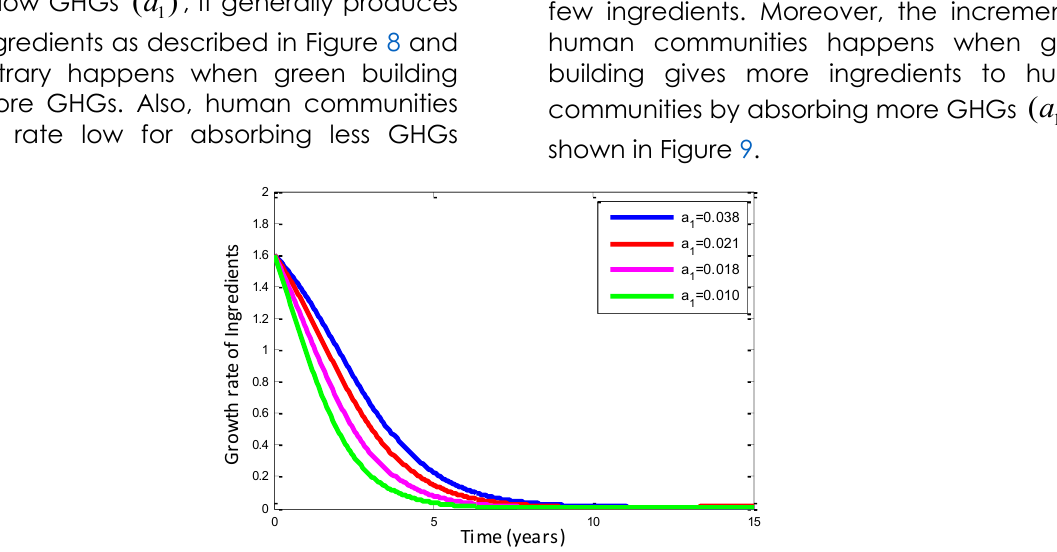
Figure 8 . The growth rate of ingredients at different values of 1 a .